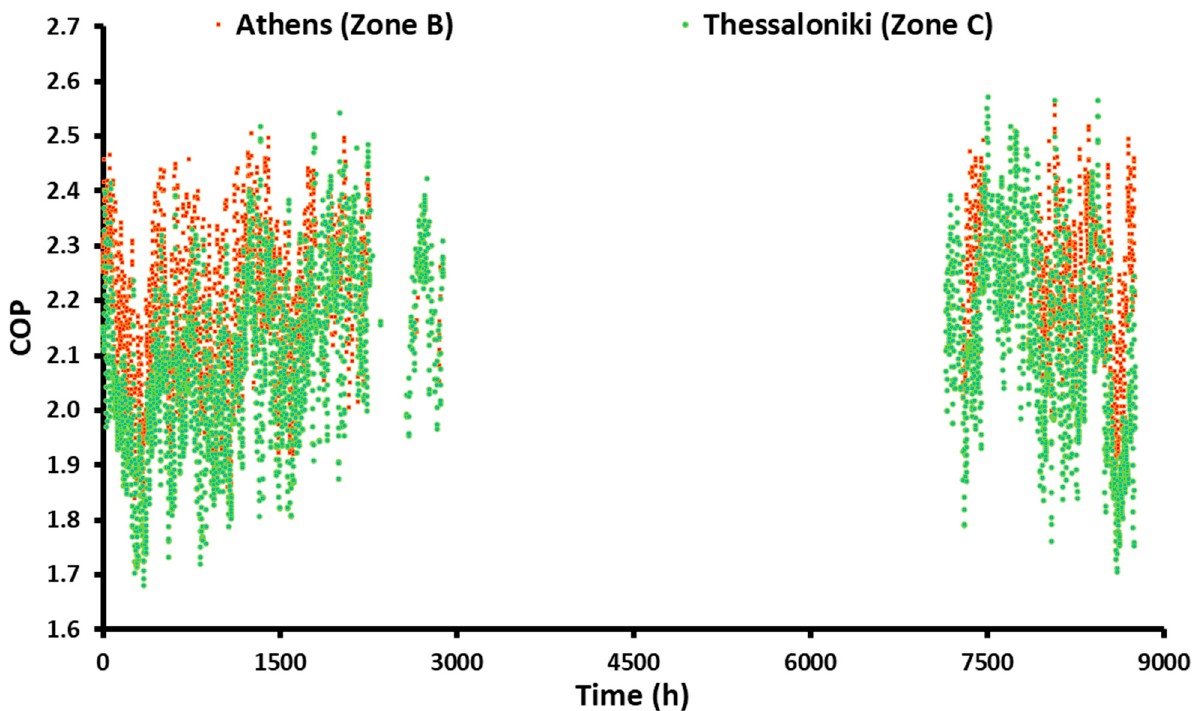
Figure 10. Heat pump system: variation in the COP during the year of operation for the examined locations.